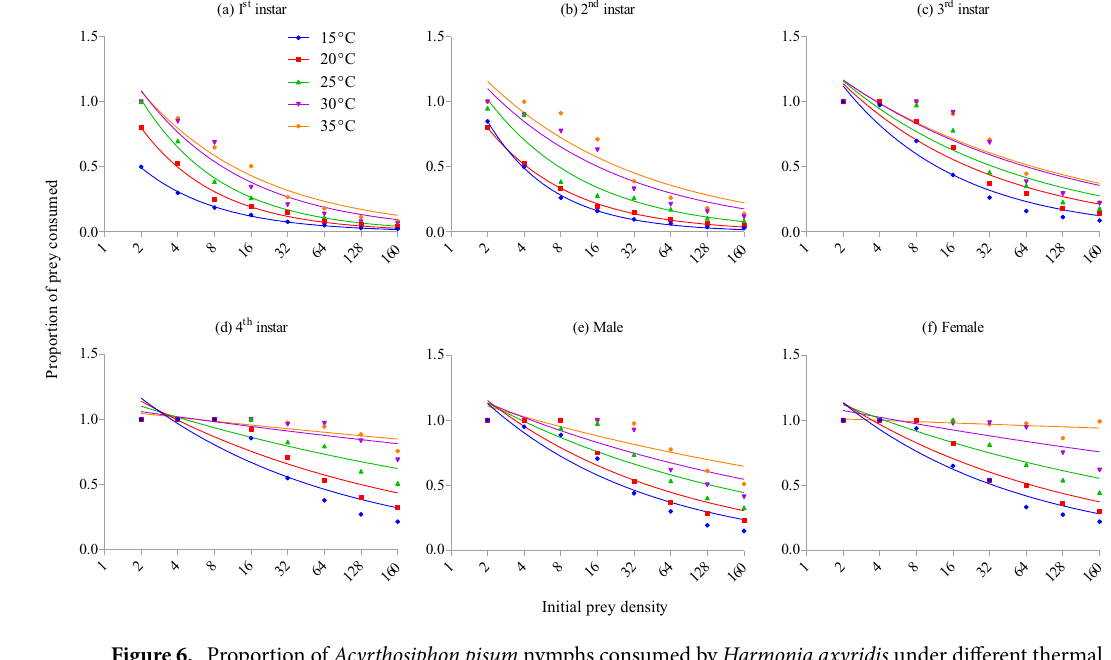
Figure 6. Proportion of Acyrthosiphon pisum nymphs consumed by Harmonia axyridis under different thermal conditions at different prey densities.